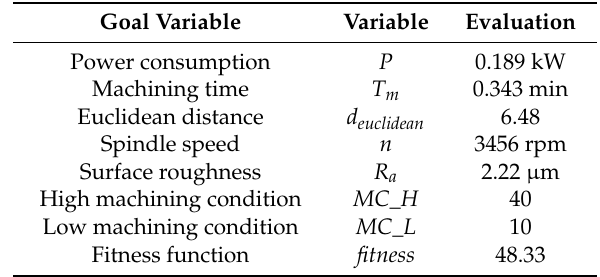
Table 17. Goal variables evaluation of the finishing operation